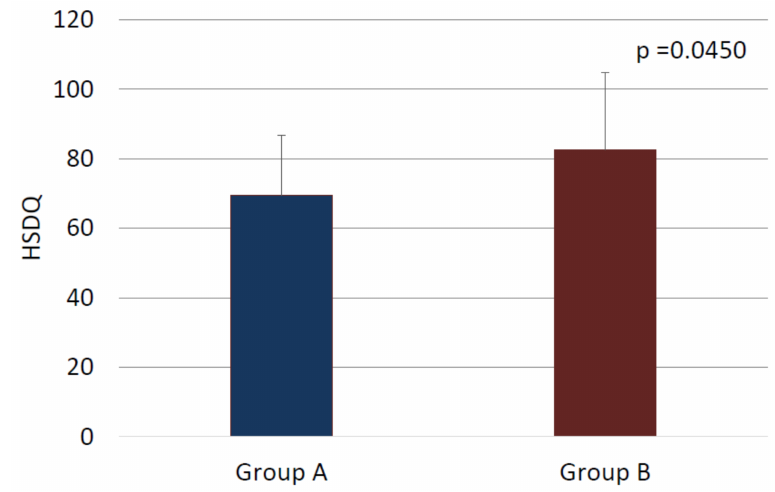
Figure 2. Comparison of depressed patients with mild or no urological symptoms (Group A, n = 70) and depressed patients with moderate or severe urological symptoms (Group B, n = 32) in terms of the sleep quality based on HSDQ.